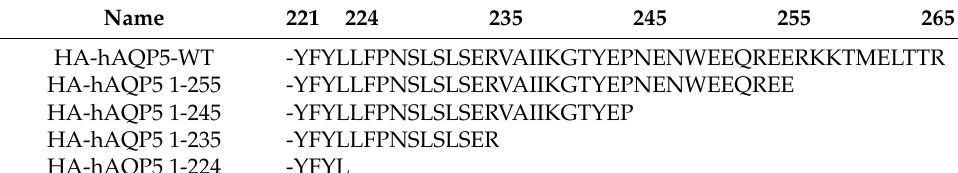
Table 1. The amino acid sequence of HA-hAQP5 C-terminal deletion mutants.